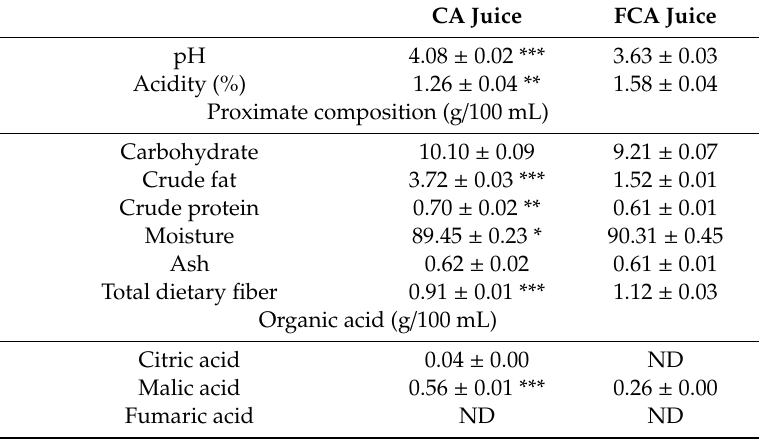
Table 1. Changes in pH value, acidity, proximate composition, organic acid, free sugar, total polyphenol, and glucosinolates contents in non-fermented cabbage-apple juice and fermented cabbage-apple juice with L. plantarium